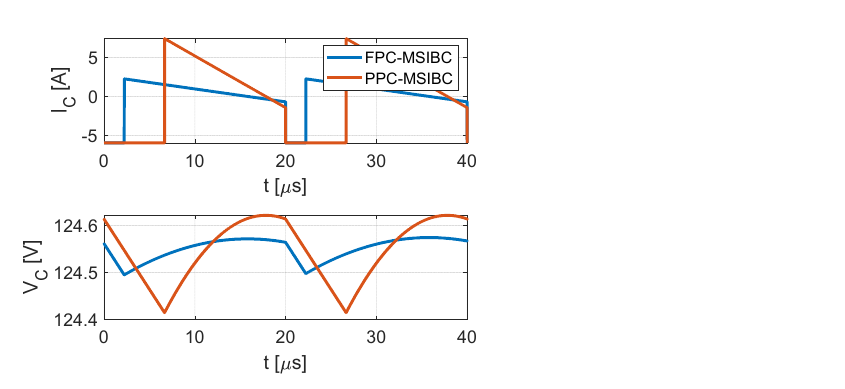
Figure 7. Capacitor’s current and voltage steady-state waveforms for the double-inductor topology.